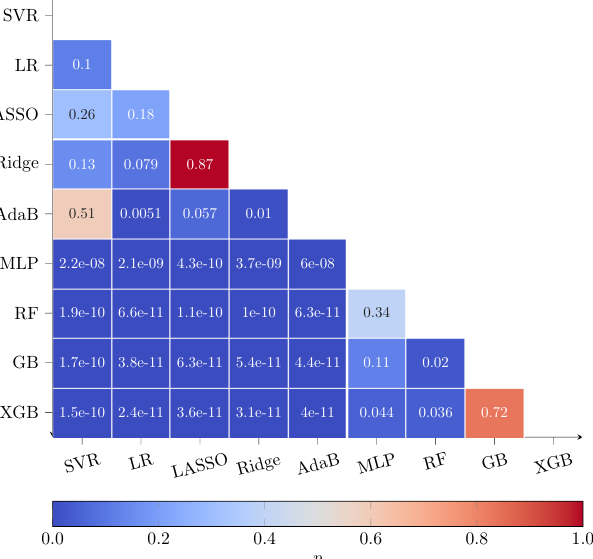
Figure 9. p values as obtained from the Wilcoxon signed-rank test for the results of the investi- gated models.